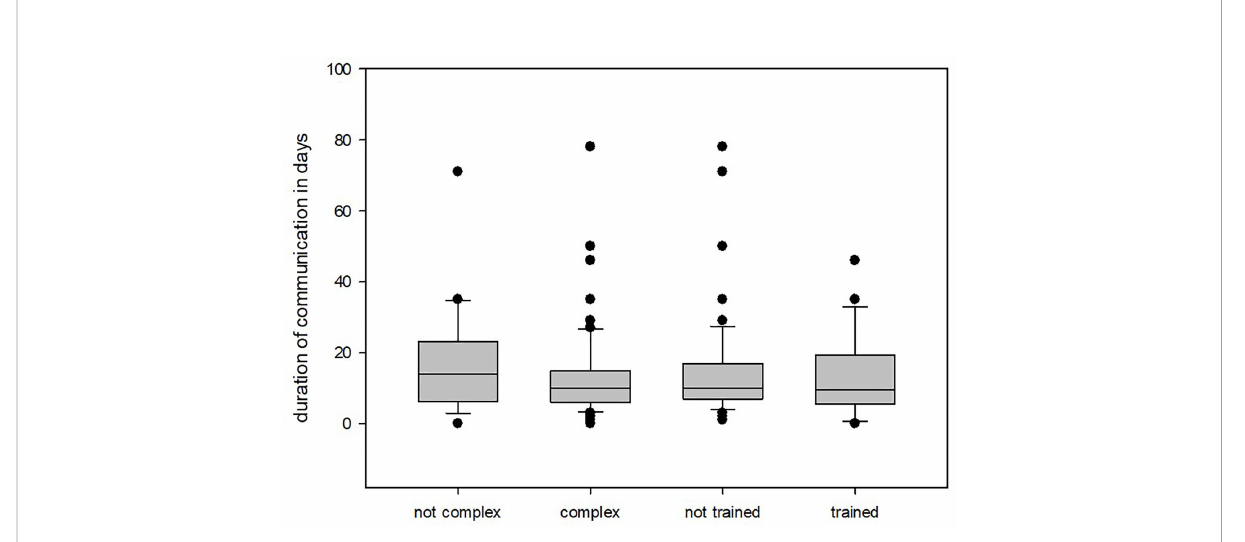
FIGURE 3 Duration of communication depending on engineer training or implant